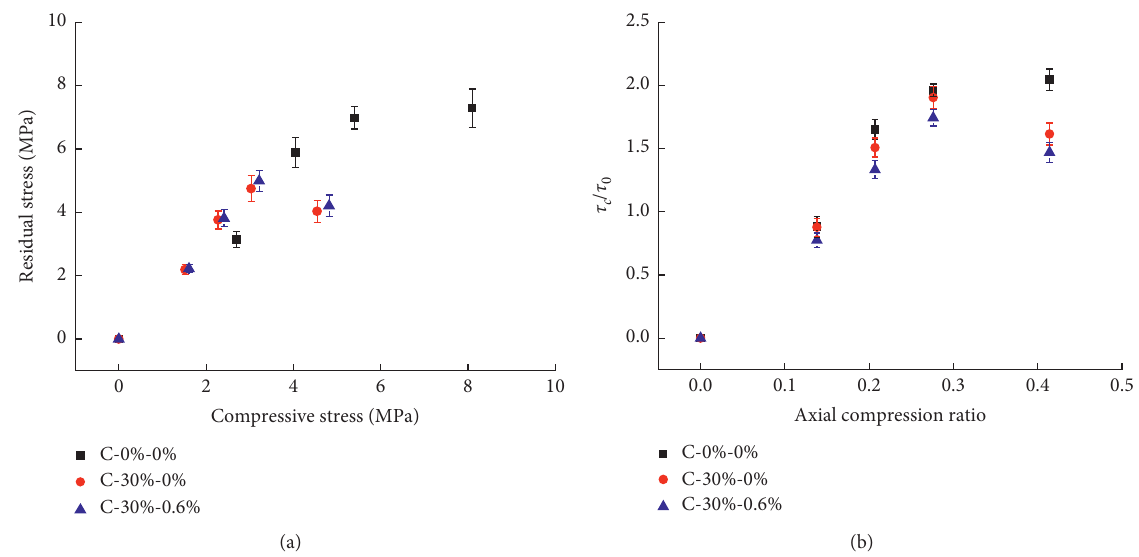
Figure 10: The relationship between the axial compressive stress and residual action of rubber fiber concrete. (a) Axial compressive stress and residual stress. (b) Axial compression ratio and residual stress variation coefficient.